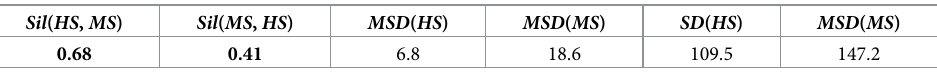
Table 2. Features for HS and MS patients.